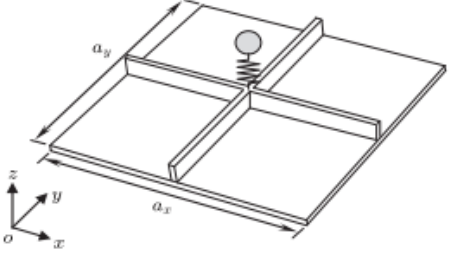
Figure 4. Schematic diagram of the unit cells of a locally resonant stiffened plate [35].